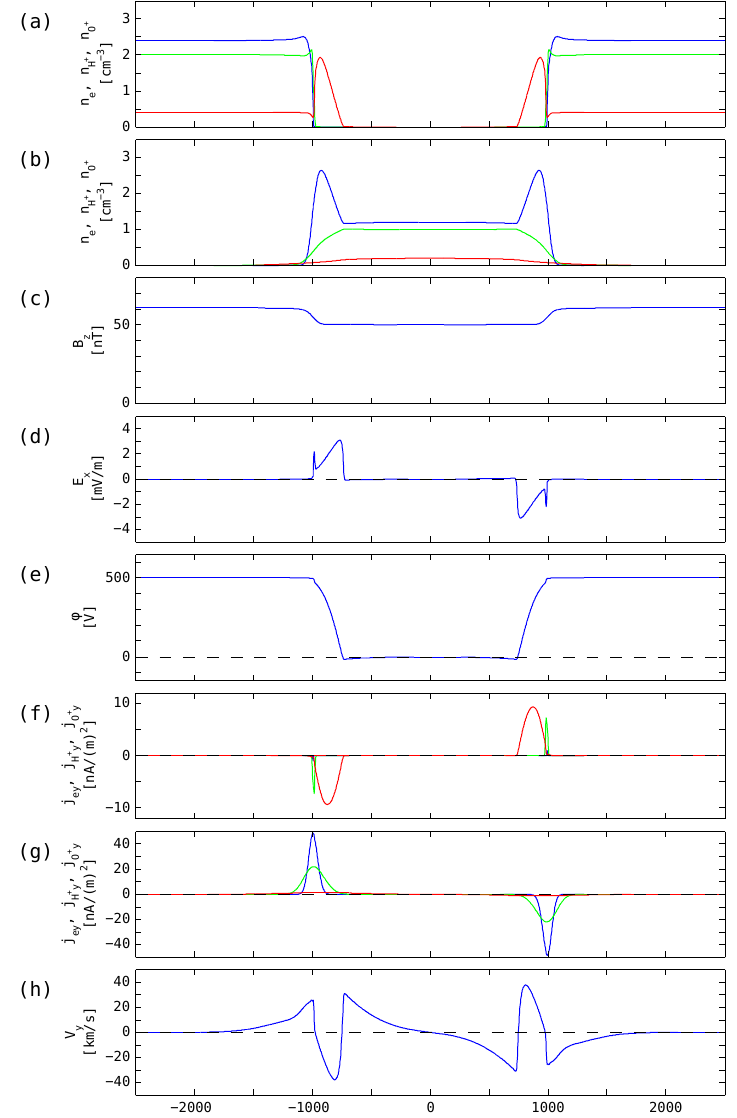
Fig. 6. Idem as Fig. 5 but now with φ( ±∞ ) =